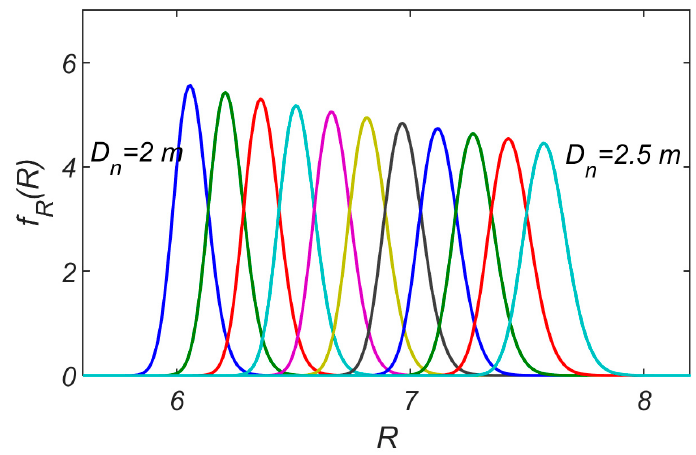
Figure 14. Probability density function of R for varying D n [unit, m ].